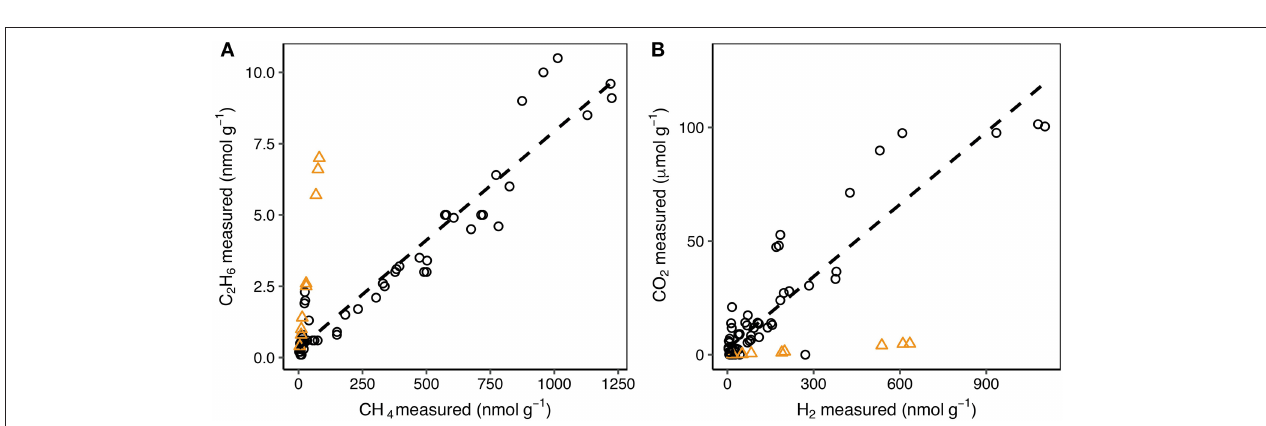
FIGURE 3 | The relationship between the amount of C 2 H 6 and CH 4 (A) and between CO 2 and H 2 (B) produced per gram of sample during grinding. Orange triangles represent analyses of ML sediment. The dashed line shows the correlation between the respective gas concentrations for all samples except ML sediment. When ML sediment is included in the highly linear relationship between C 2 H 6 and CH 4 , the R 2 drops from 0.93 to 0.79. When ML sediment is included in the linear relationship between CO 2 and H 2 , the R 2 drops from 0.86 to